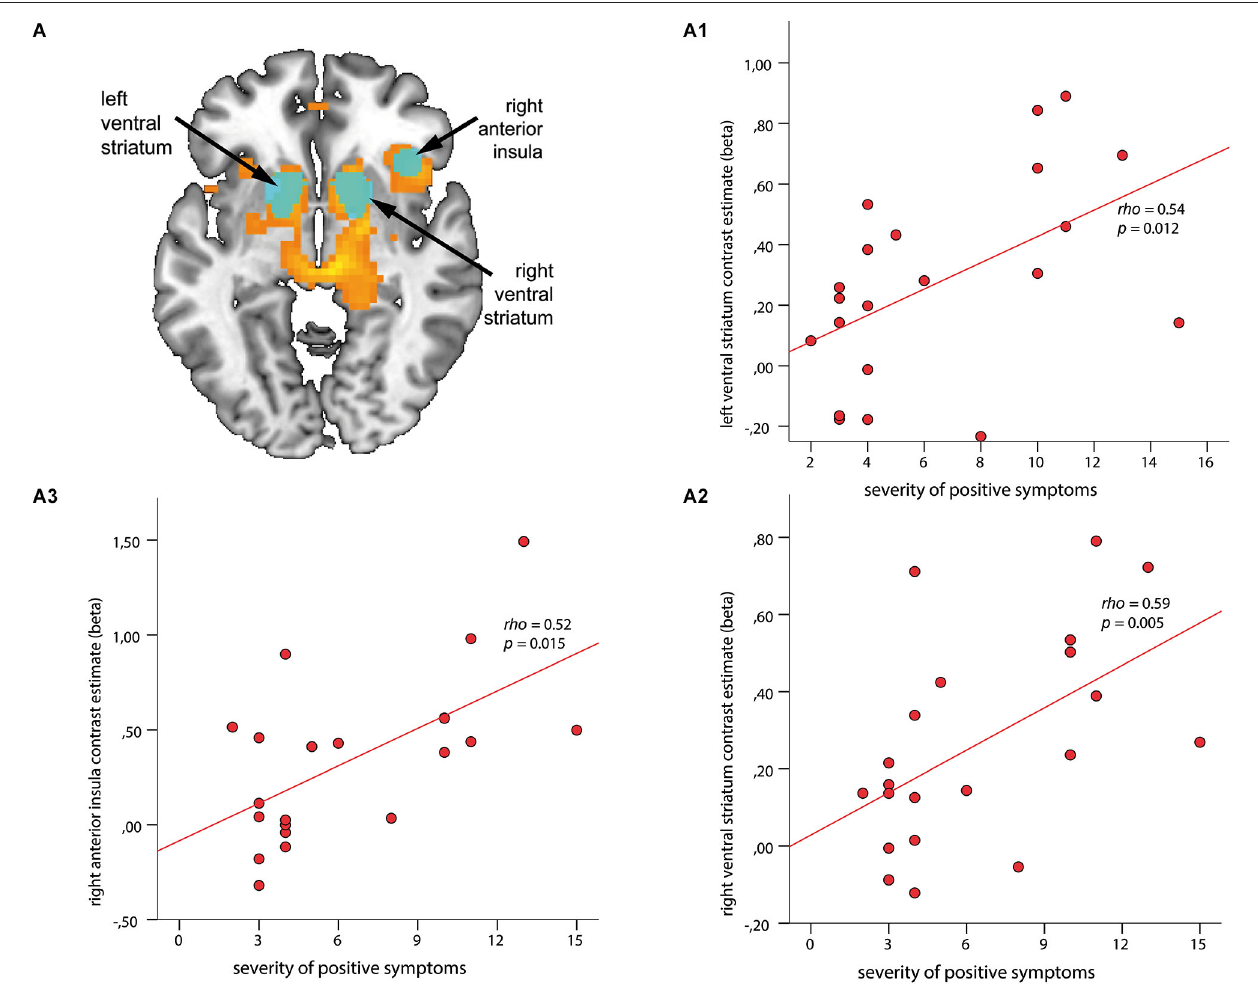
orange, both at a voxel-wise threshold p < 0.001, with an extent of 20 voxels). ROI-based analysis revealed significant association between contrast estimates of the left and right ventral striatum (VS) (A1, A2) and right anterior insula (rAI) (A3) with positive symptom scores ( ρ > 0.52, p <